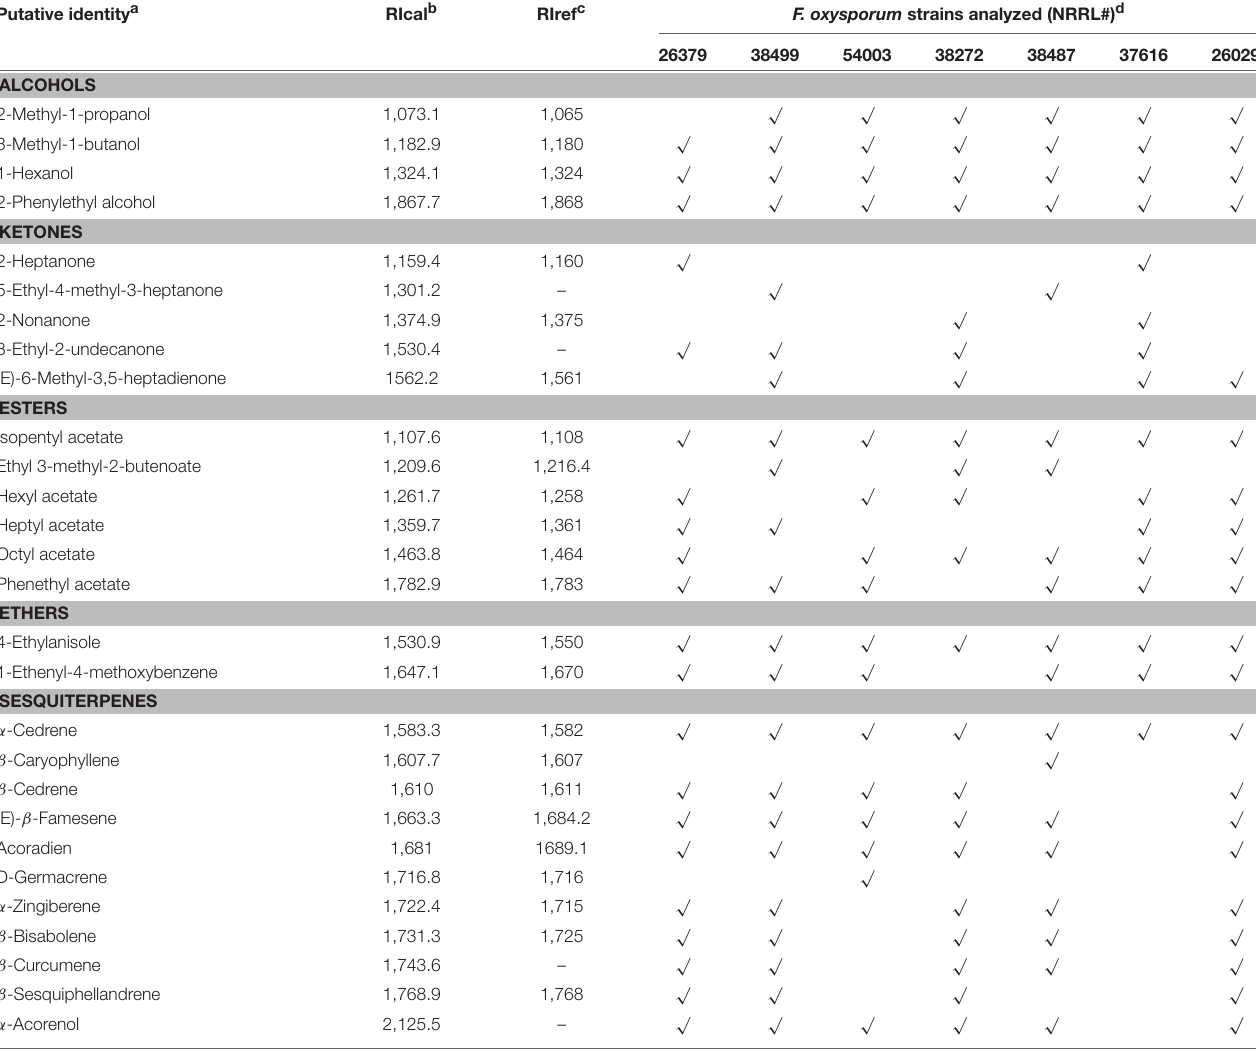
TABLE 5 | VCs produced by seven F. oxysporum